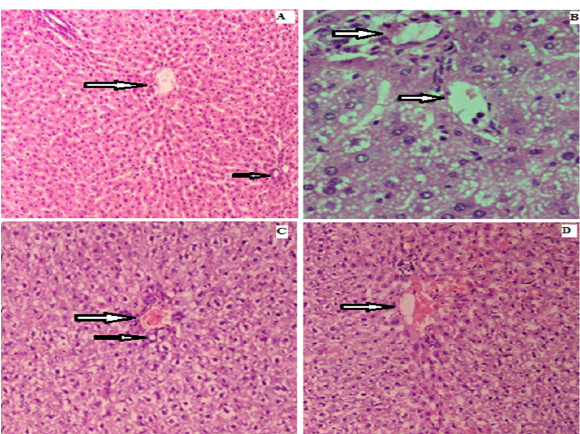
Figure 10. Photomicrographs of microsection of liver of rat ( A ) control group showing the normal histological structure of hepatic lobules and normal portal traid, ( B ) diabetic group showing focal necrosis and apoptosis of hepatocytes associated with mononuclear cell infiltration, ( C ) Rp ‐ Nc 0.5 mg treated group showing slight hydropic degeneration along restoring histological structure of hepatic lobules, ( D ) Rp ‐ Nc 1 mg treated group showing restoration of normal histological structure of hepatic lobules and normal portal traid (H & E scale bar 25 μ m). The photomicrograph of pancreas of rat histopathology from normal control group revealed showing the normal histological structure of islets of Langerhans with normal pancreatic acini in comparison to ruptured and destructed islets of Langerhans with damage in beta cells in diabetic control group (Figure 11). Administration of Rp ‐ Nc at dose concentrations showing some normal islets of Langerhans with some mild destructed in normal pancreatic duct and in between normal pancreatic acini towards normal.